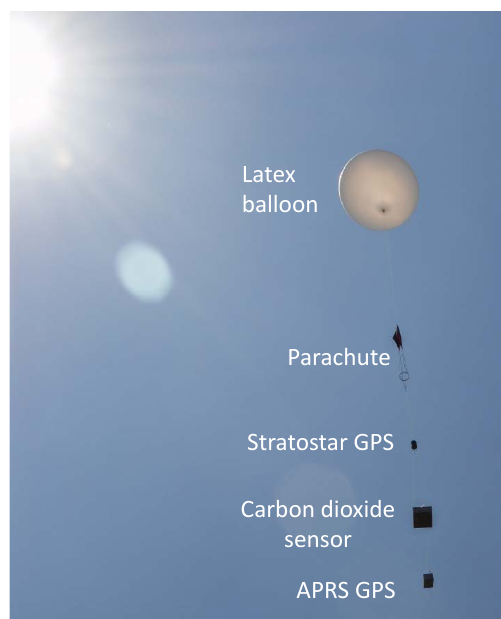
Figure 2. Picture of flight train of packages. The total package weight of 5.4kg was lifted by a 200g latex balloon that was filled with industrial-grade helium. The packages were all connected with 1.8m lines (mason’s string), except for 5.5m lines for the balloon to parachute